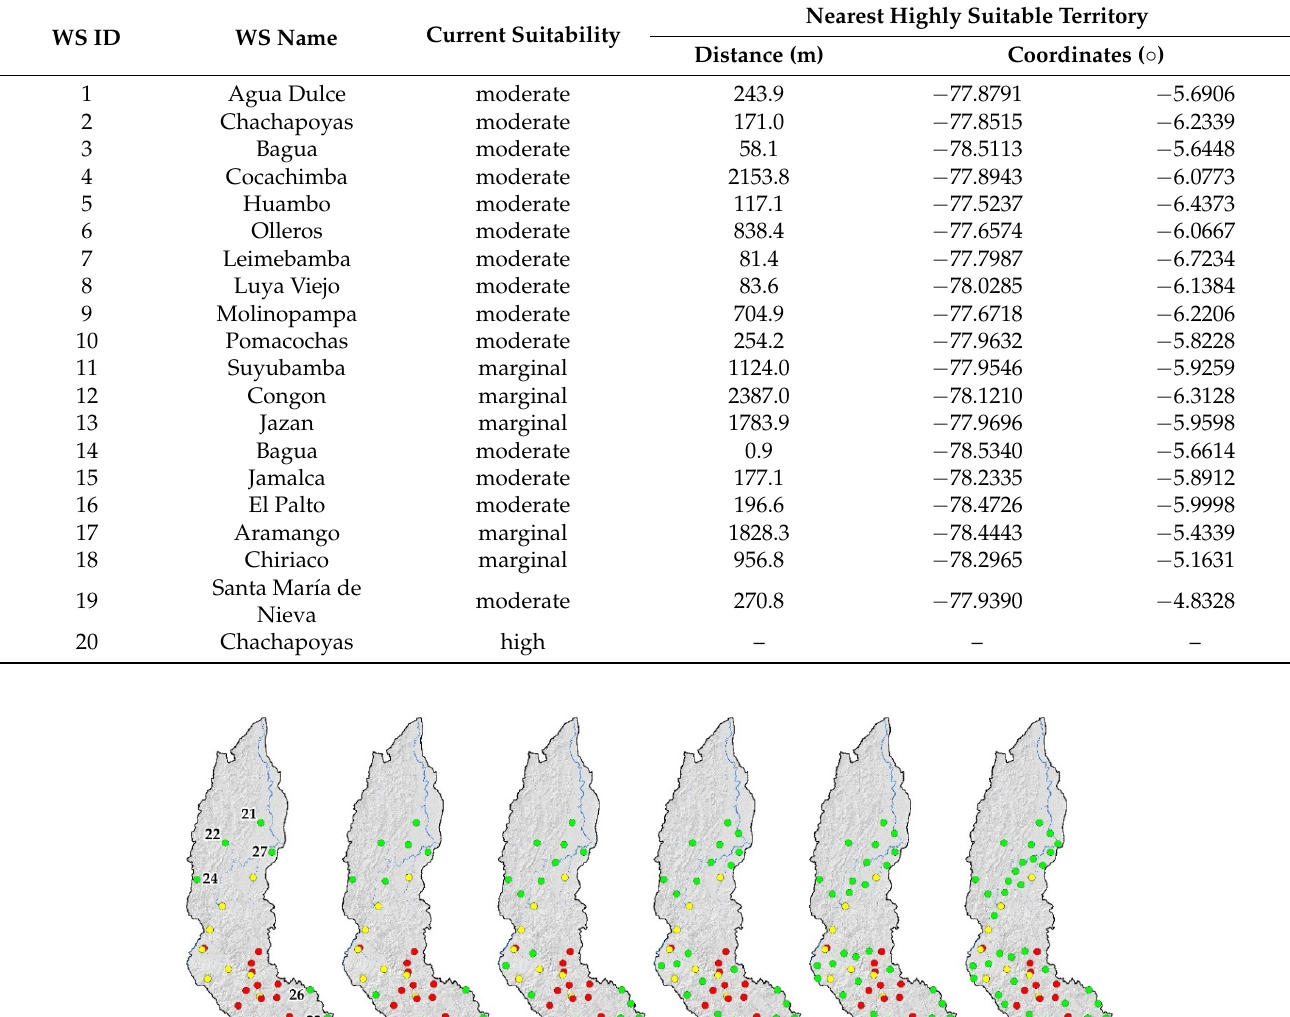
Table 7. Suitability of the existing WS sites and very suitable locations closer to them in Amazonas, NE Peru.